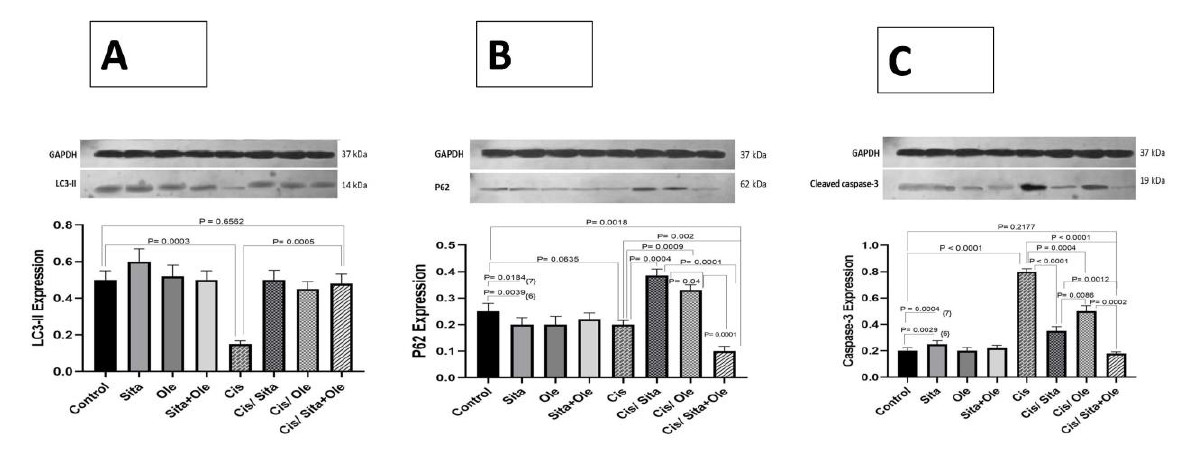
Fig. 7. Effects of cisplatin, Sita and OLE on protein expression of LC3-II (A) , P62 (B) , and Cleaved caspase-3 (C) in renal tissue, as shown by Western blot analysis. Bars represent corresponding protein expression levels relative to GAPDH. Values are expressed as the means ± S.D. P < 0.05 is considered statistically significant; one-way ANOVA followed by Bonferroni-corrected post hoc tests were